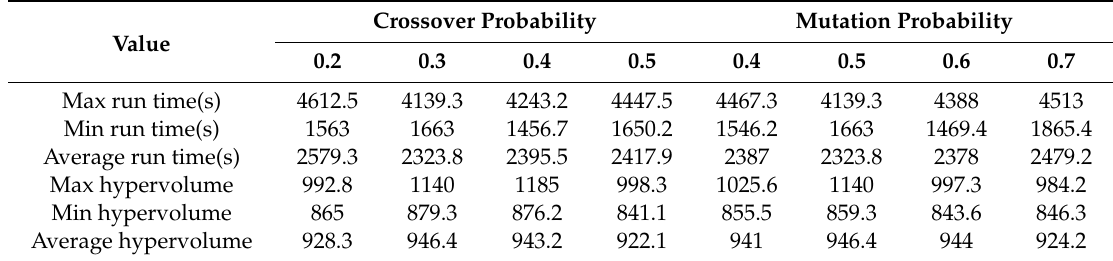
Table 6. Run time and hypervolume under di ff erent crossover probability and mutation probability.